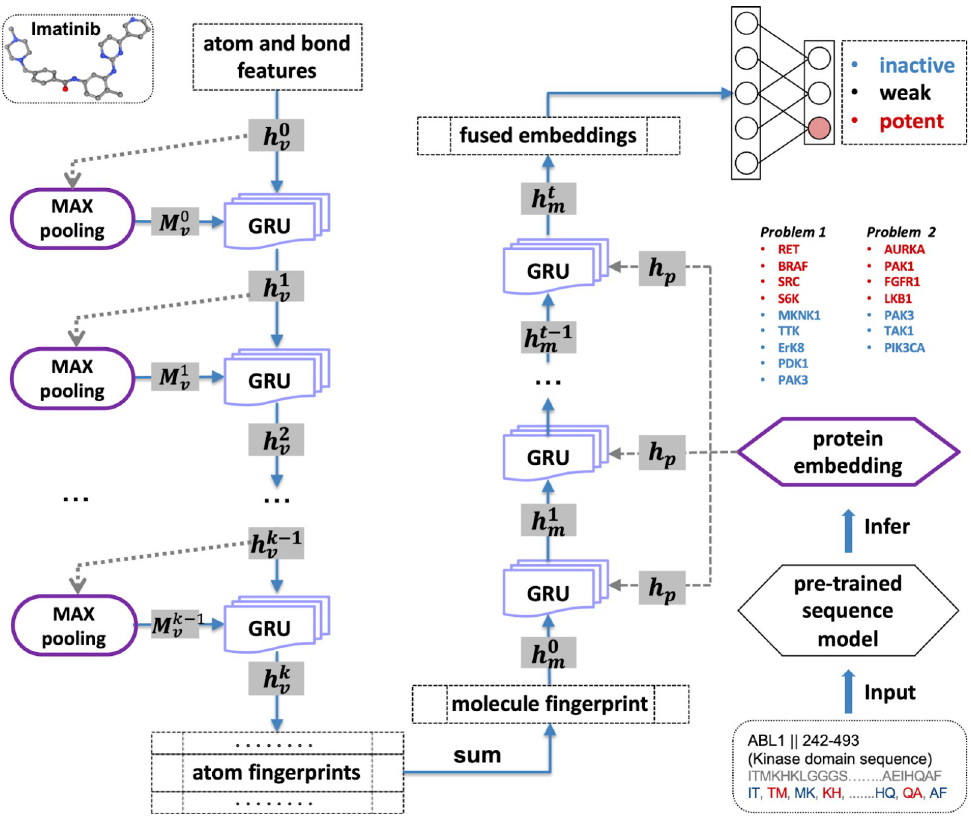
Fig 5. A schematic summarizing FEMTD (Zhaoping Xiong’s method). The molecule is embedded with graph neural fingerprints and the target proteins are represented as sequences and pretrained with a language model (doc2vec) model. These two embeddings are fused together to classify the binding affinity as inactive, weak, or